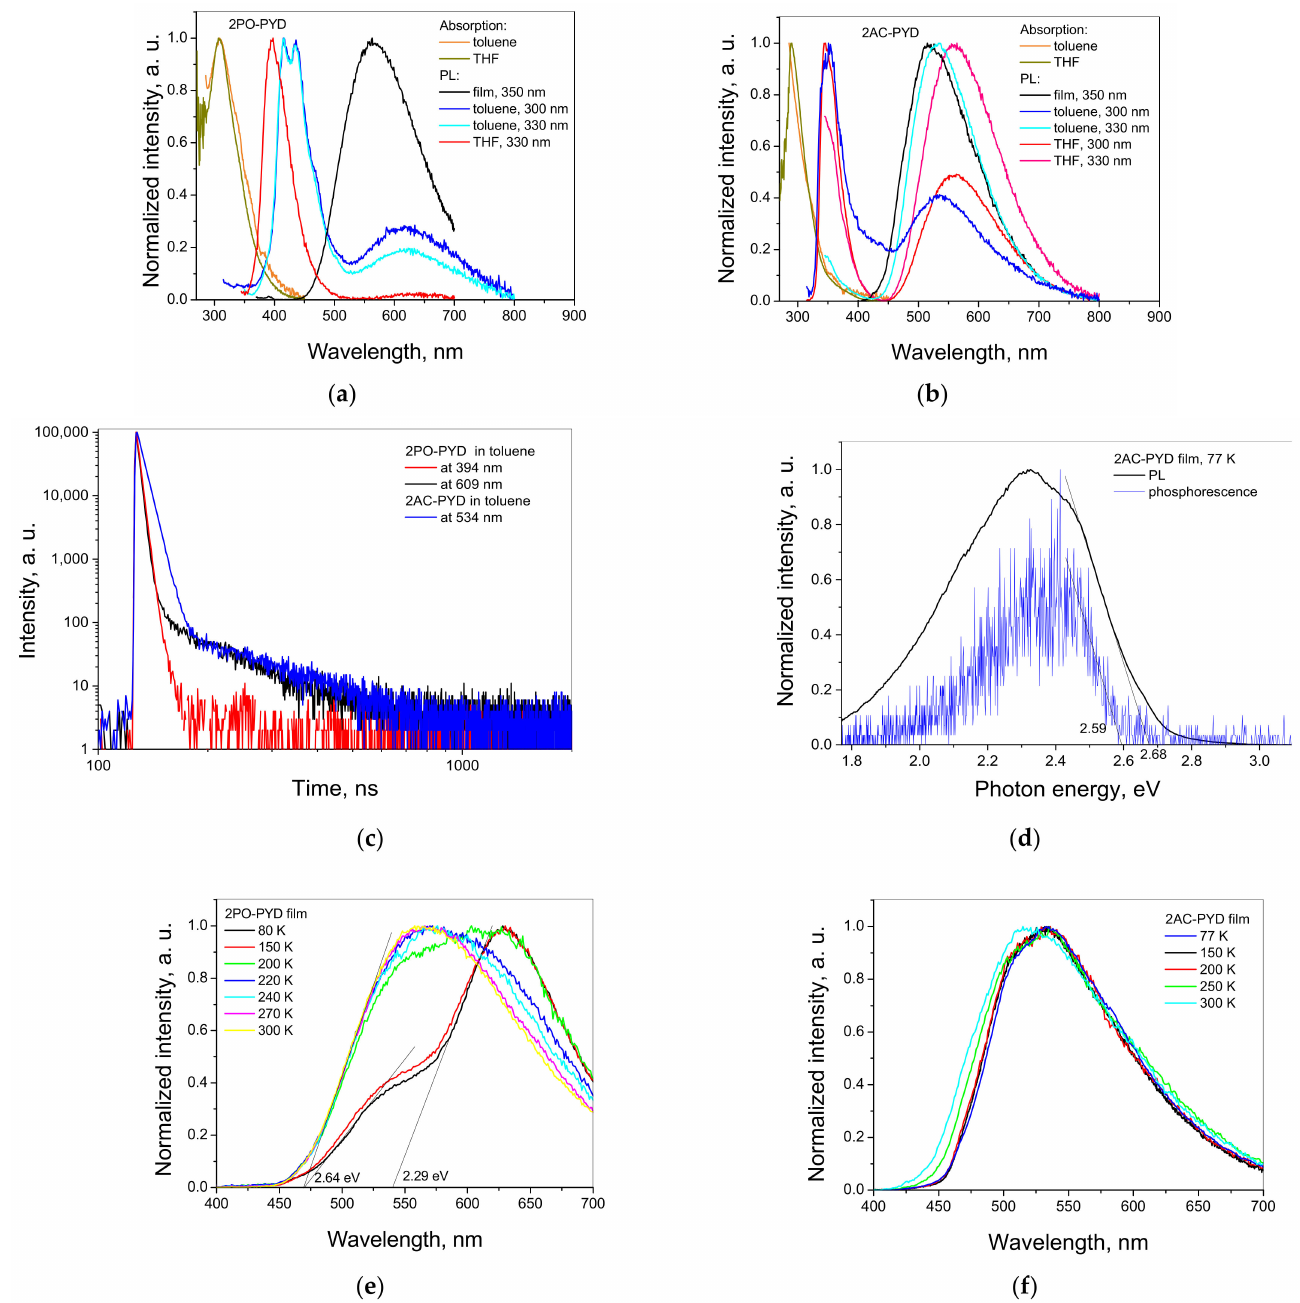
Figure 5. Absorption and PL spectra of toluene, THF solutions, and films of 2PO-PYD ( a ) and 2AC-PYD ( b ). PL decay curves of deoxygenated toluene solutions ( c ). PL and phosphorescence spectra of the film of 2AC-PYD recorded at liquid nitrogen temperature ( d ). PL spectra of the films of 2PO-PYD ( e ) and 2AC-PYD ( f ) recorded in inert atmosphere at different temperatures. The absorption spectra are characterized by the prominent band at 308 nm for the solutions of 2PO-PYD and 288 nm for those of 2AC-PYD . The positions of the absorption peaks almost did not change when changing the non-polar toluene solvent with the polar THF. DFT predicts that this band originates from the locally excited (LE) state of donor fragments (Figure S6). The very low oscillator strength of 0.002 of the transition of the ICT state (S 0 → S 1 ) is apparently the reason for the lack of this absorption band in the experimental UV